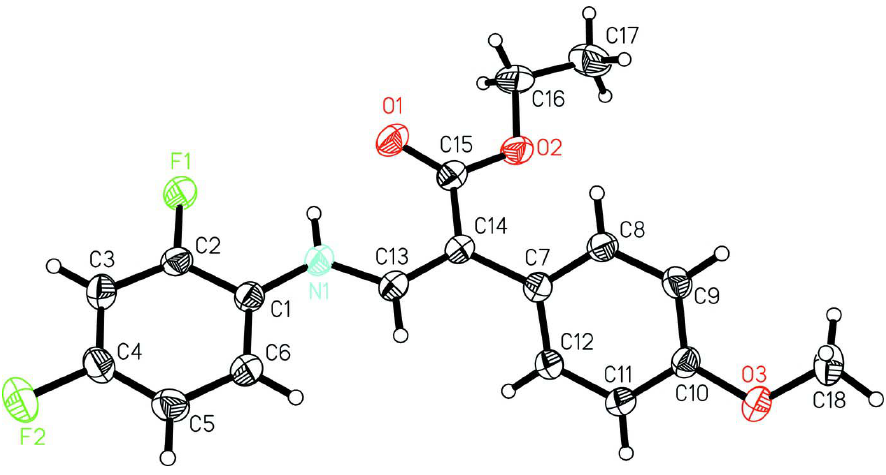
Figure 1 Molecular structure of the title compound, showing the atom-numbering scheme. Displacement ellipsoids are drawn at the 30% probability level. Dashed lines indicate H-bonds.